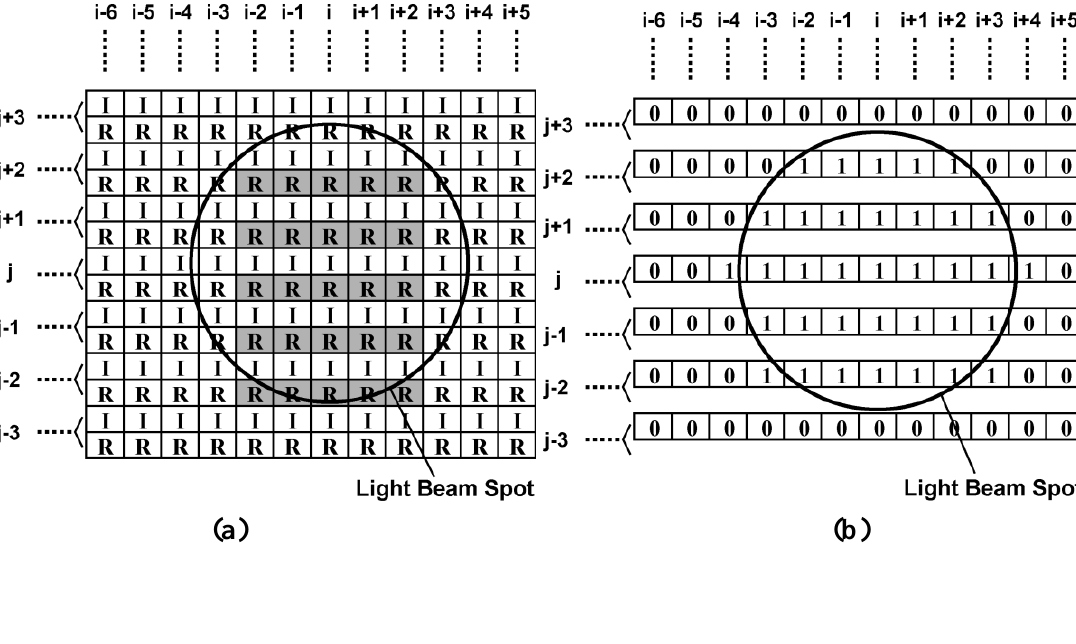
Figure 8. (a) Light beam spot and (b) Binary image of the light beam